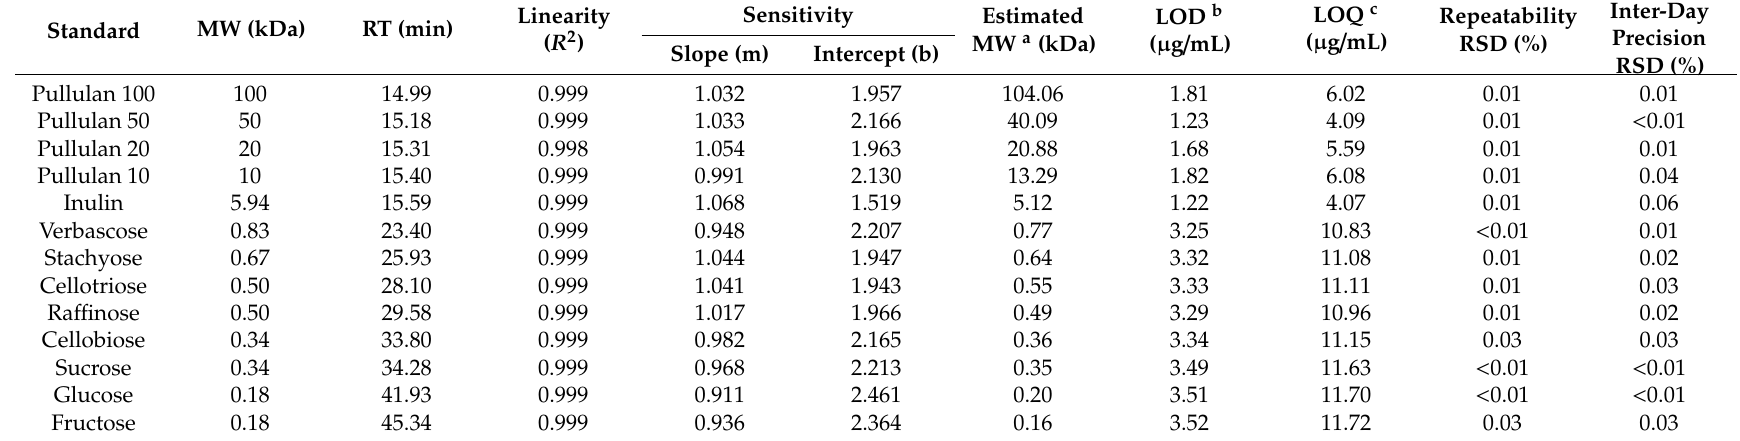
Table 3. Linearity, sensitivity, molecular weight estimation and precision of carbohydrates standards by